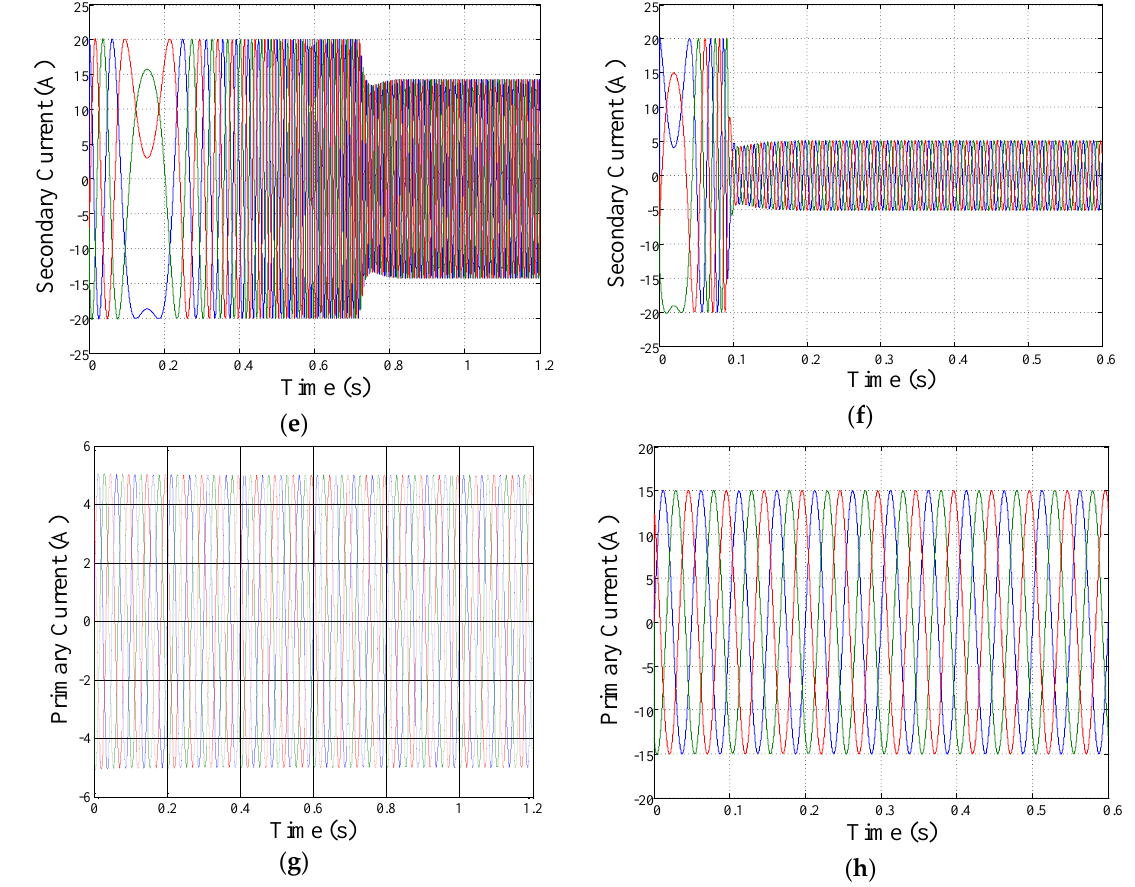
Figure 14. Simulation results of the start-up of the motor under load: ( a ) speed curve for i *pd = 5 A; ( b ) speed curve for i *pd = 15 A; ( c ) torque curve for i *pd = 5 A; ( d ) torque curve for i *pd = 15 A; ( e ) secondary current curve for i *pd = 5 A; ( f ) secondary current curve for i *pd = 15 A; ( g ) primary current curve for i *pd = 5 A; and( h ) primary current curve for i *pd = 15 A.